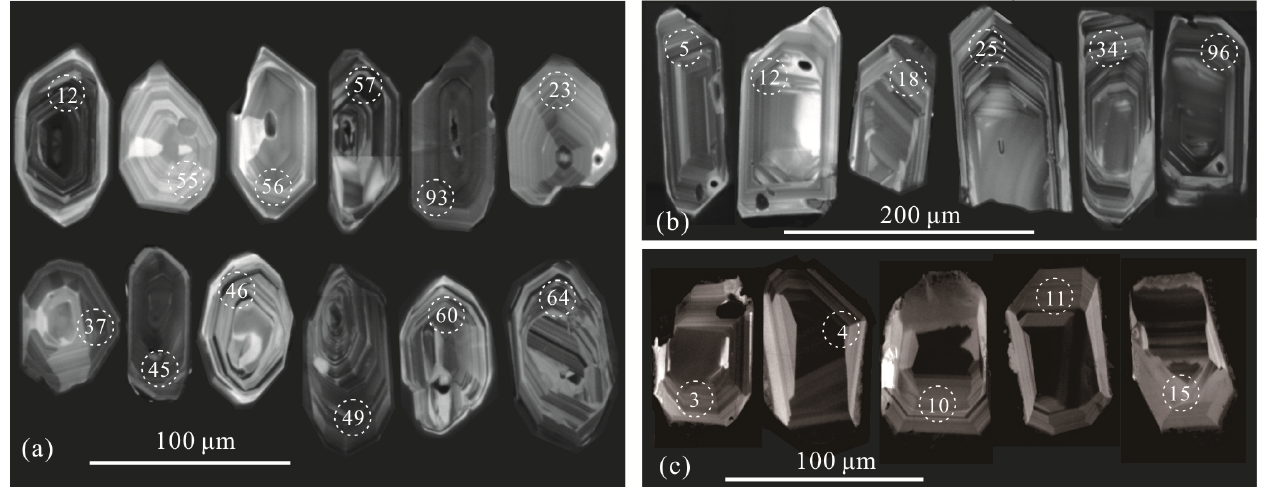
Figure 4. Cathodoluminescence (CL) images of typical detrital and magmatic zircons from the Tuchengzi Formation in well YD1. Circles indicate the location of laser ablation inductively coupled plasma source mass spectrometry, numbers in circles refer to the spot number. ( a ) Sample YD1 ‐ 464; ( b ) sample YD1 ‐ 50; and ( c ) sample YD1 ‐ 878.